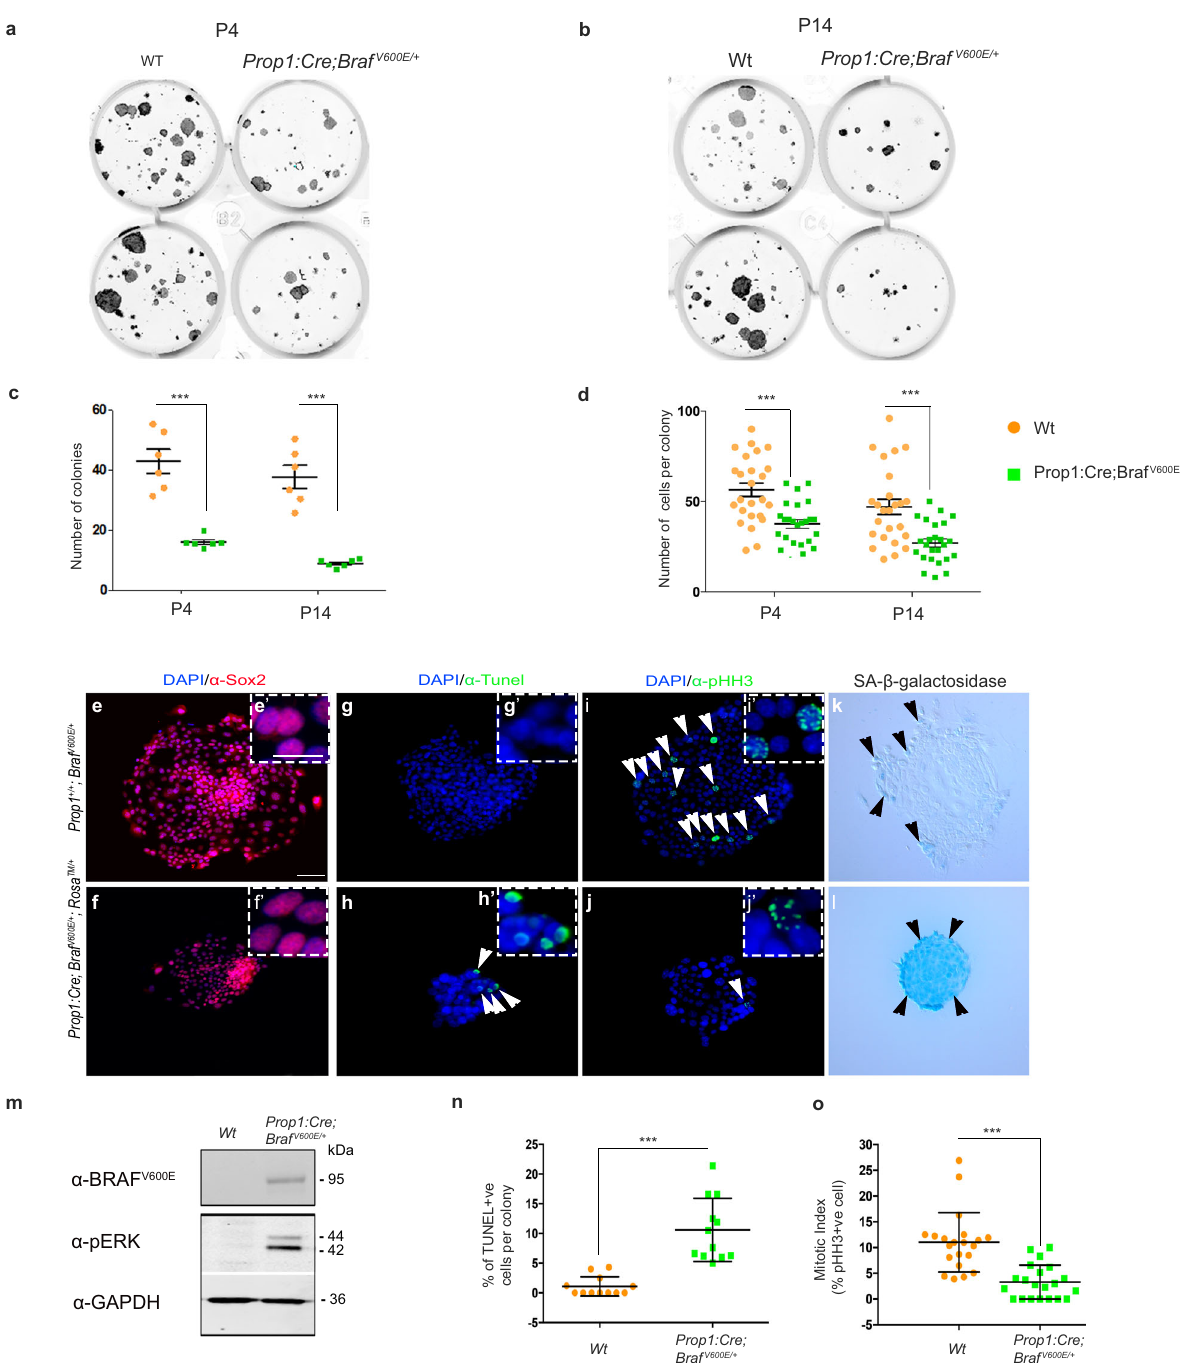
Fig. 10 Expression of Braf p.V600E in postnatal pituitary stem cells leads to decreased proliferation and increased apoptosis in vitro. PSC cultures from Wt and Prop1:Cre;Braf V600E/ + at postnatal stage P4 ( a ) and P14 ( b ) reveal a signi fi cant decreased capacity in colony formation ( c ) and number of cells per colony ( d ) in mutant PSCs compared to Wt. The ability of the mutant PSCs to form colonies diminishes over time from P4 to P14 ( c ). Immunostaining with the PSCs marker Sox2 revealed that all the cells in culture are Sox2 + ve ( e , f ). TUNEL immuno fl uorescence revealed a signi fi cant increase in apoptotic cells in the mutant PSC colonies (arrowheads in h and quanti fi cation n ) while almost no apoptotic cells were seen in the Wt colonies ( g , n ). Immuno fl uorescence against pHH3 revealed a substantial decrease in pHH3 + ve cells in the mutant PSCs (arrowhead in j ) compared to Wt (arrowheads in i ). o Quanti fi cation of the number of pHH3 + ve cells per colony shows a signi fi cant decrease in the mitotic index in the mutant PSC colonies compared to Wt. The Prop1:Cre;Braf V600E/ + mutant colonies express the senescence SA- β -galactosidase (arrowheads l ) while only a few positive cells were detected in Wt (arrowheads in k ). Western blotting of PSC lysate revealed expression of Braf p.V600E resulting in increased pERK in the Prop1:Cre;Braf V600E/ + mutant PSCs compared to Wt. *** statistically signi fi cant p < 0.001, unpaired two-tailed Student ’ s T -test, data represented as mean ±SEM (number of colonies and cells per colony of three mutants and three Wt from three independent experiments performed in triplicates c , d ); n number of TUNEL + ve cells per colony of 12 colonies from three mutants and three Wt; o number of pHH3 + ve cells of 21 colonies from three mutants and three Wt. Images are representative of three independent experiments. Scale bar in e ′ and e represent 50 and 10 µ m